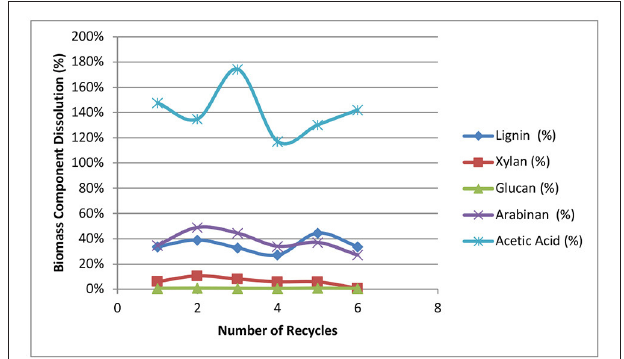
FIGURE 8 | The effects of recycling weak black liquors on biomass component dissolution.